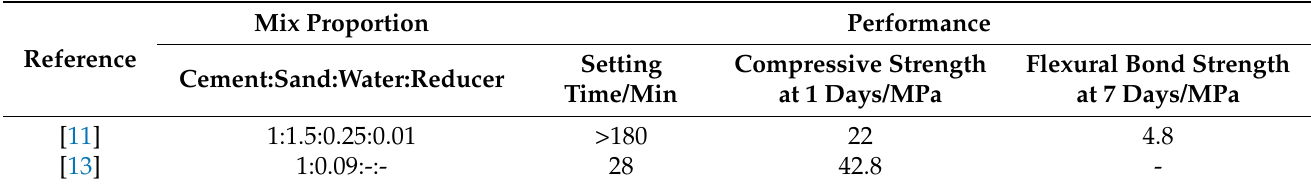
Table 4. Properties of Ordinary Portland cement mortar and Rapid-Hardening cement mortar.